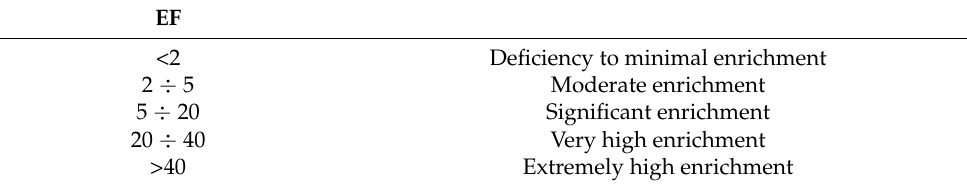
Table 2. Contamination categories based on EF